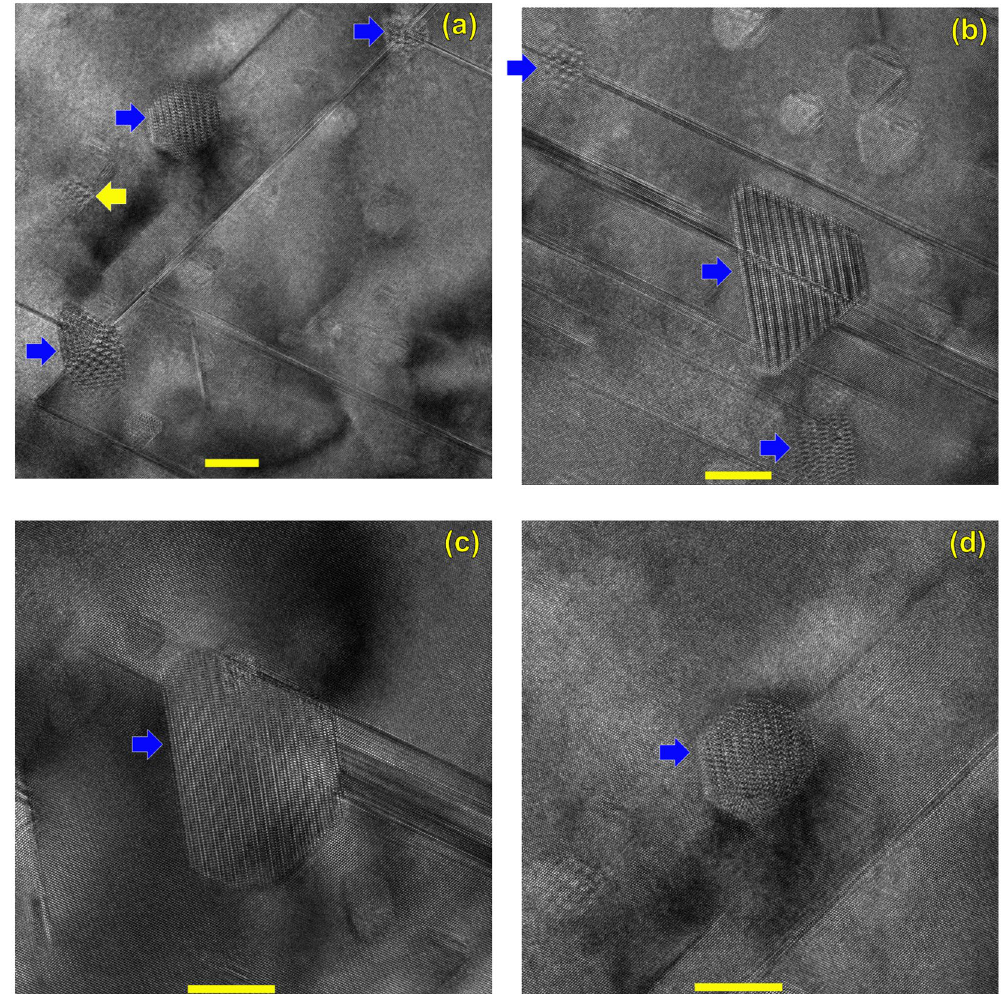
Figure 2. HRTEM images on the [101] zone. Several apparent second-phase precipitates, arrowed, are present. Most or all of these precipitates are located adjacent to a Frank loop (blue ⇒ arrows), and one appears not to be adjacent to a Frank loop (yellow ⇐ arrow). All scale bars 10